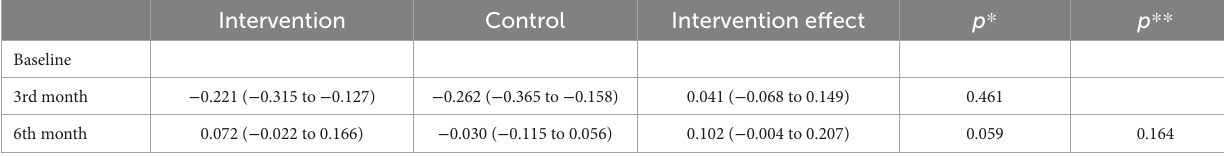
TABLE 5 Change in the proportion of stair use to elevator use on the ground floor (stair descending rate) per time slot. Intervention